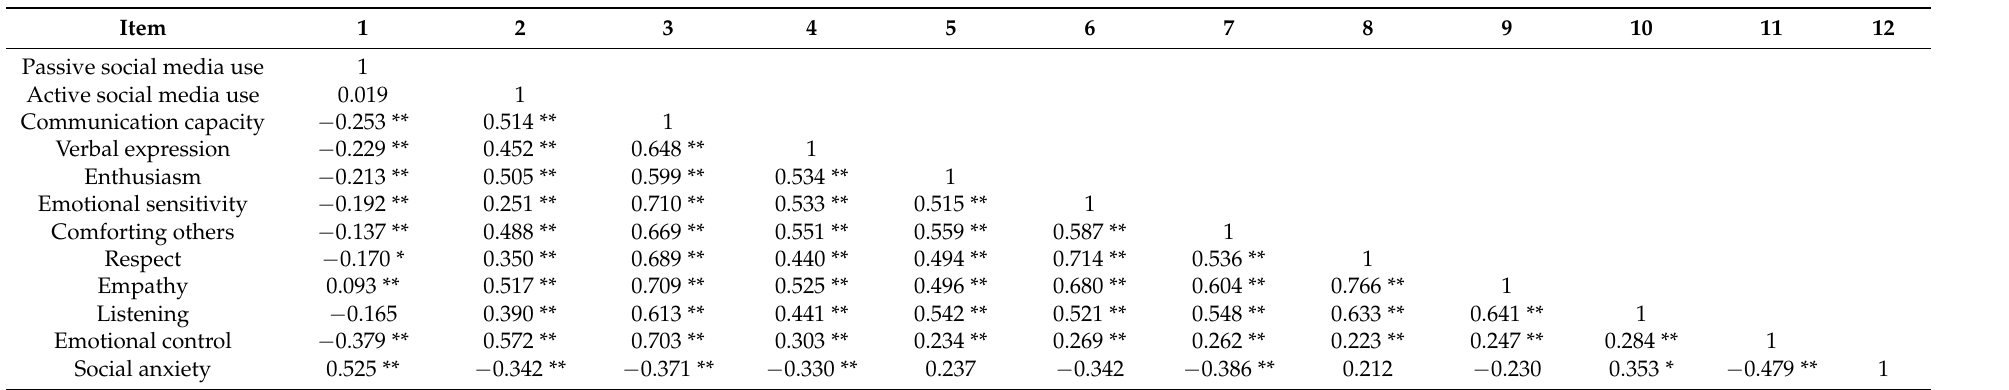
Table 2. Correlation analysis of social media use, communication capacity, and social anxiety